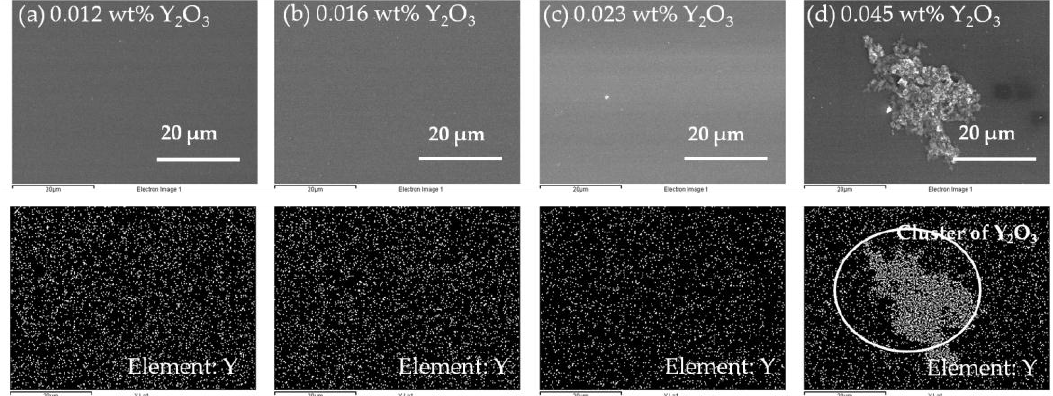
Figure 6. EDX images showing the distribution of yttrium: ( a ) 0.012 wt %; ( b ) 0.016 wt %; ( c ) 0.023 wt %; and ( d ) 0.045 wt %.